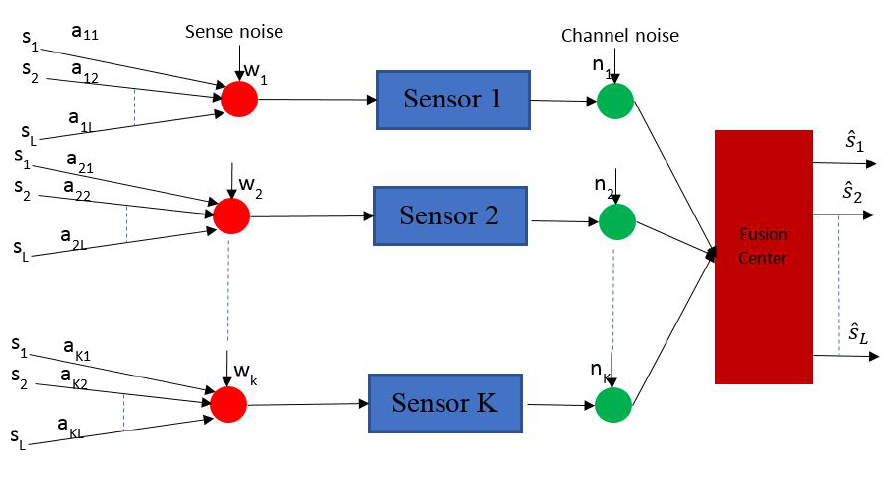
Figure 20. Data flow of noise perturbed data from the sensors in a cluster to the fusion center